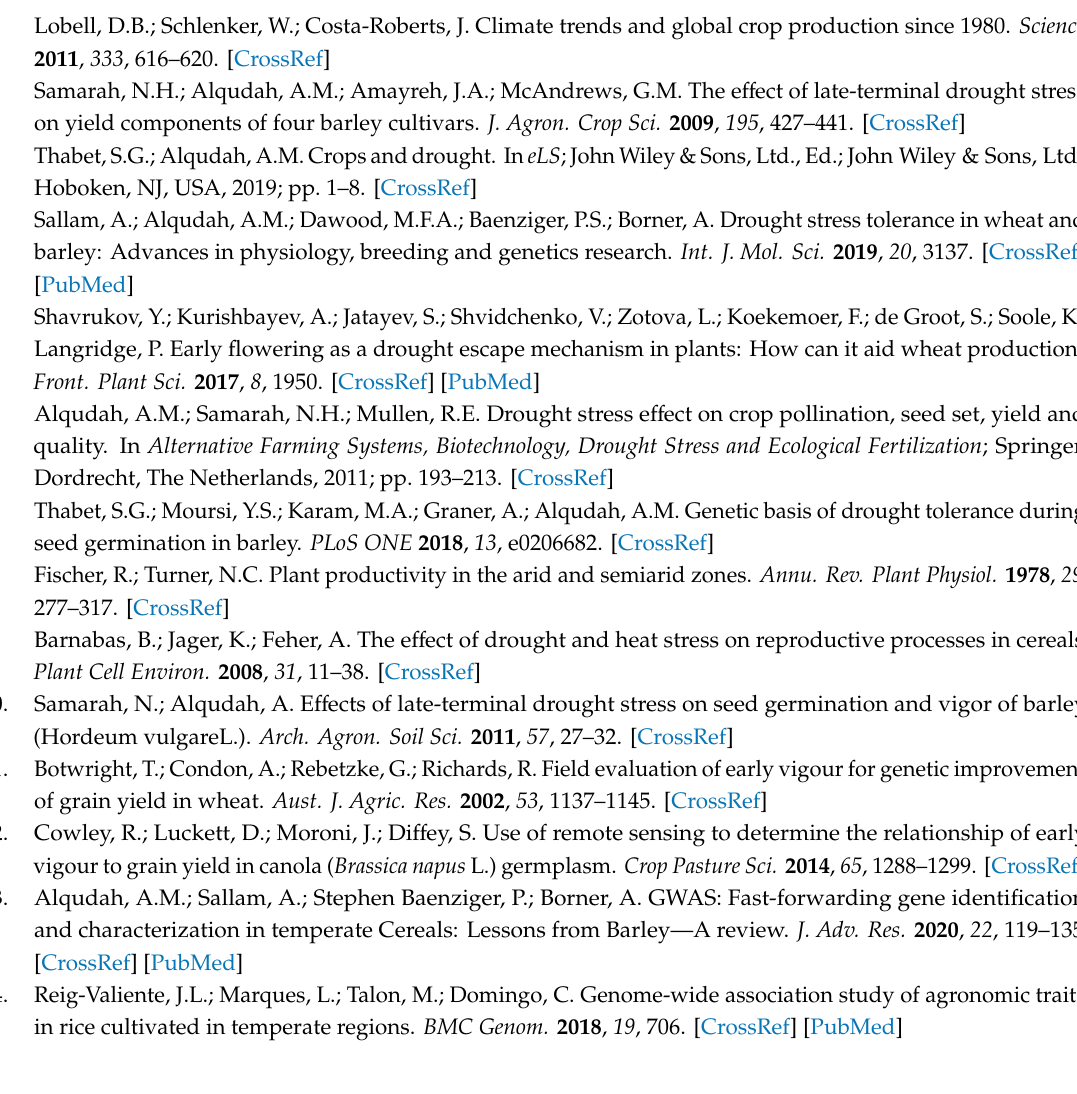
Figure S1: Population structure based on their row type (two-rowed vs. six-rowed), geographical of origin; Figure S2: Weather data at Fayoum station that indicates Max-Min Temperature and Humidity; Figure S3: Boxplot analysis of variation of the traits; Figure S4: Boxplot analysis of drought tolerance index variation of the traits in barley genotypes under control and drought stress; Figure S5: Correlations matrix among drought tolerant index; Table S1: Summary of the most significant SNP associated with studied